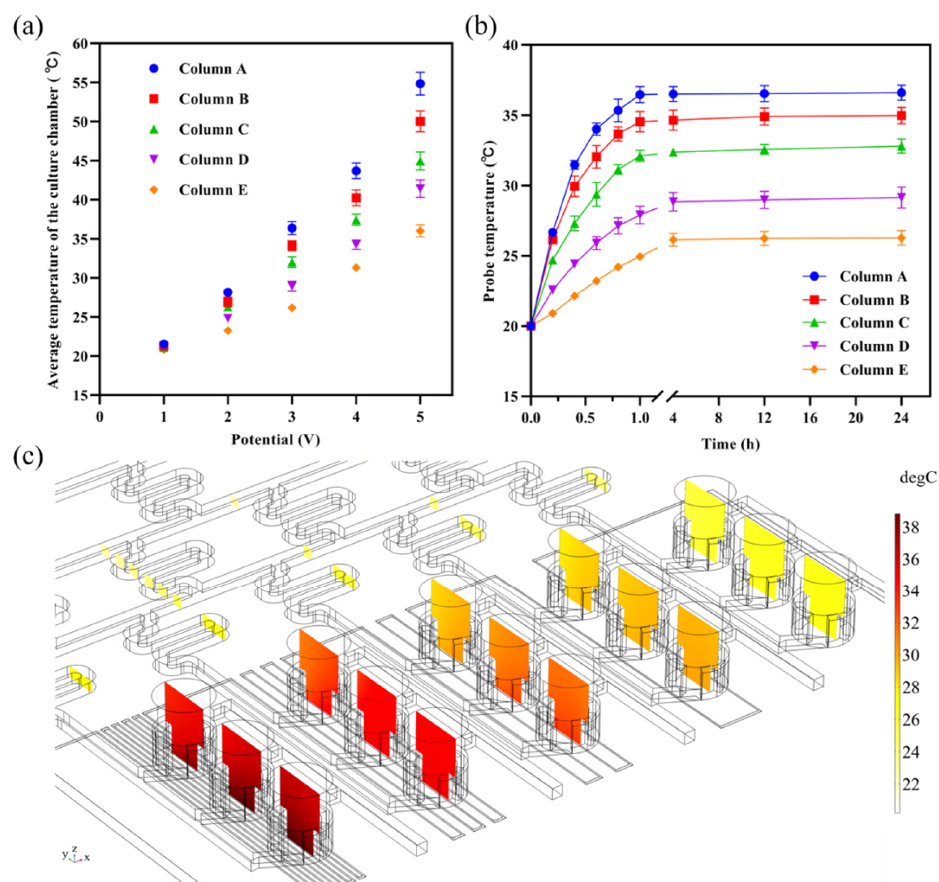
Figure 4. Temperature profiles of the coral polyp culture chip. ( a ) The average temperature of polyp culture chambers under different potentials. ( b ) Temperature variation over time within the coral polyp culture chambers. ( c ) Temperature profile of polyp culture chip at 3 V voltage under steady state. The values of the temperature are shown in the legend on the right.